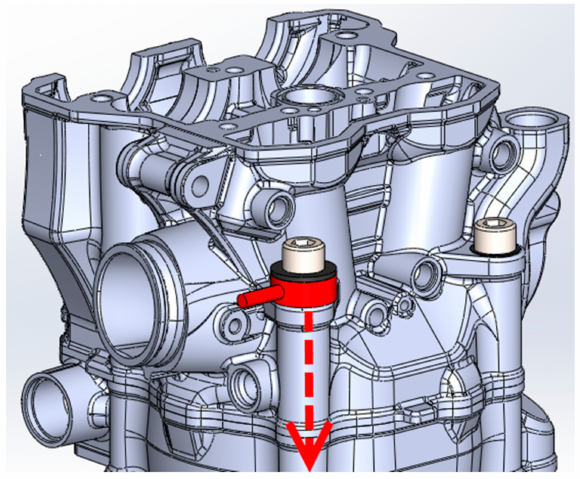
Figure 1. Stress on the engine head screw (illustrative